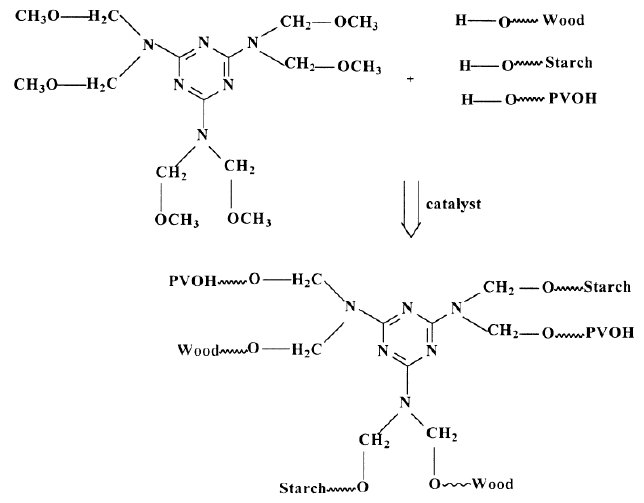
Figure 5. Possible cross-linking reaction of starch-based wood adhesive in the presence of hexamethoxymethylmelamine (Cymel 323) [91], Reproduced with permission from